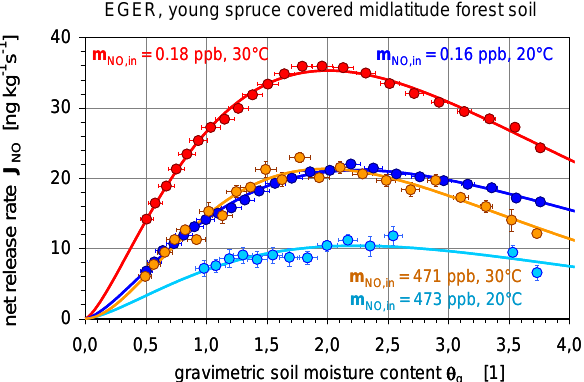
Figure 11. As Fig. 10, but for a sample taken from an organic-rich forest soil covered with young spruce (Fichtel Mountains, SE Ger- Fig. 11: as Fig. 10, but for a sample taken from an organic rich forest soil covered with many). young spruce (“Fichtelgebirge”, SE Germany).